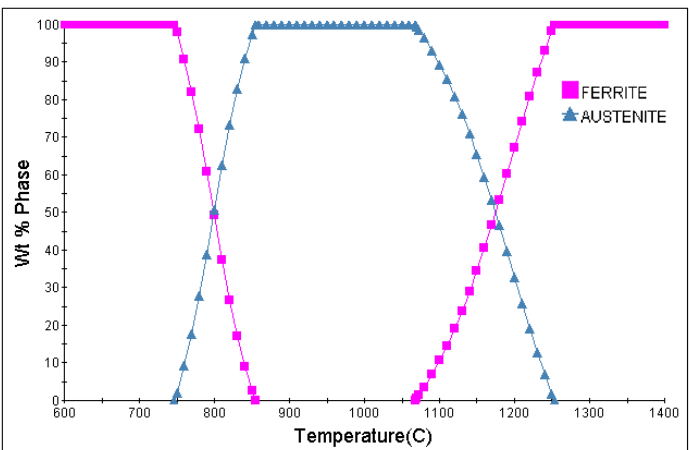
Figure 3. The equilibrium phase diagram of the employed low-carbon ferritic stainless steel calculated by JMatPro software.